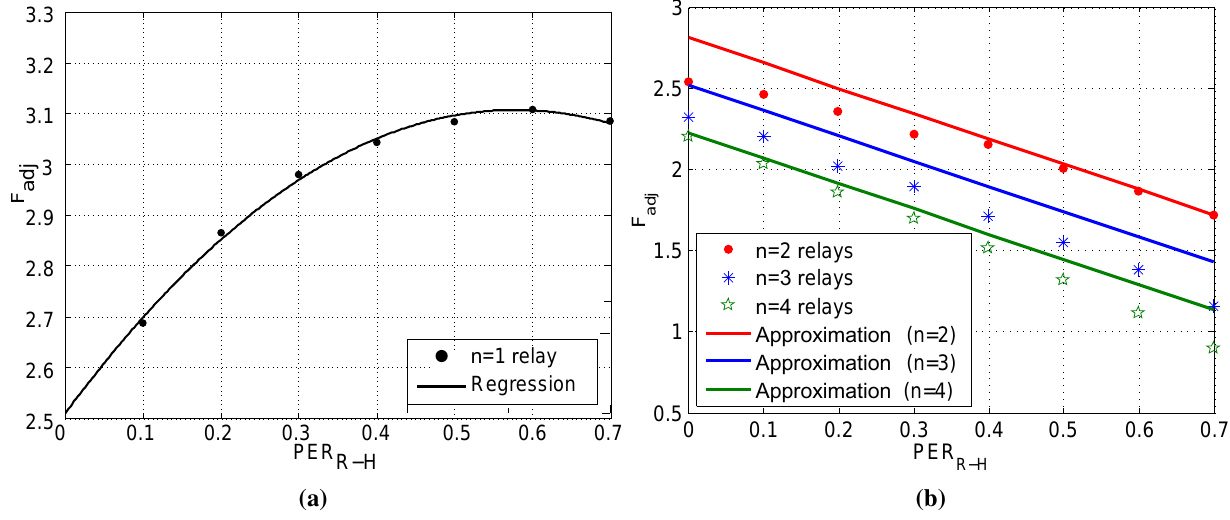
Figure 4. Adjustment factor ( F